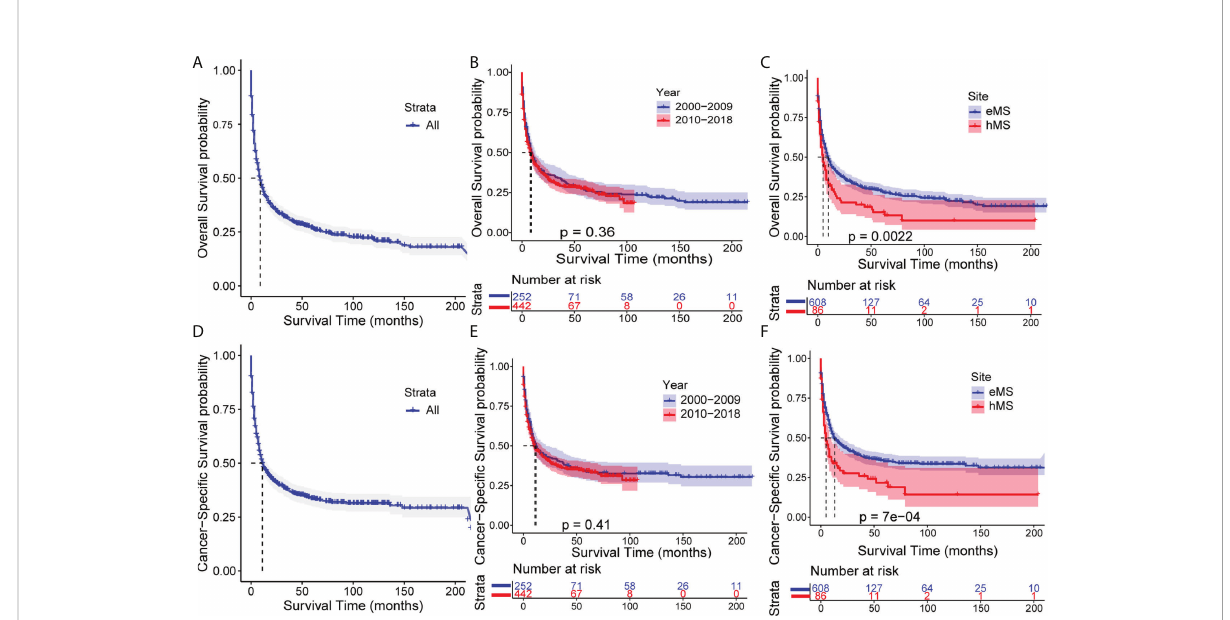
FIGURE 2 Kaplan – Meier analysis of overall survival (OS) and cancer-speci fi c survival (CSS) in MS. Kaplan – Meier survival curves of OS for all patients (A) , patients strati fi ed by year of diagnosis (B) and primary sites (C) . Kaplan – Meier survival curves of CSS for all patients (D) , patients strati fi ed by year of diagnosis (E) and primary sites (F) . eMS, MS excluding those involving hematopoetic sites; hMS, MS involving hematopoetic